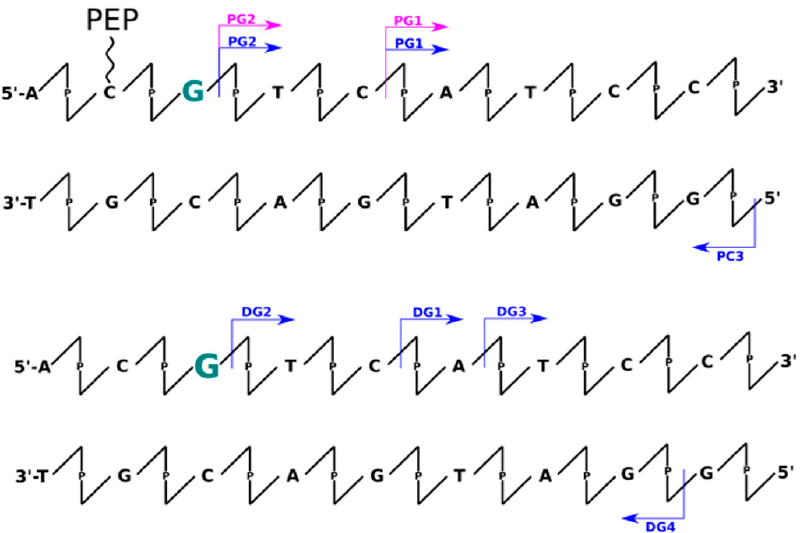
Figure 3. Schematic representation of all identified oligonucleotides’ fragments by means of LC-MS for BrdG labeled systems (upper with peptide conjugate, lower without peptide conjugation). The scheme represents only part of the dsDNA structure. The arrows represent the respective fragments identified for X-ray radiation experiments (blue), UV irradiation by 320 nm photons (pink), and 280 nm photons (orange). Modified nucleobase was pointed in green. Below the arrows the names of identified fragments are listed starting with “P” stands for system with peptide conjugation, starting with “D” without peptide conjugation. Additionally, the interstrands cross-links (ICL) were observed. For possible mechanisms, please see Figures S7–S11.